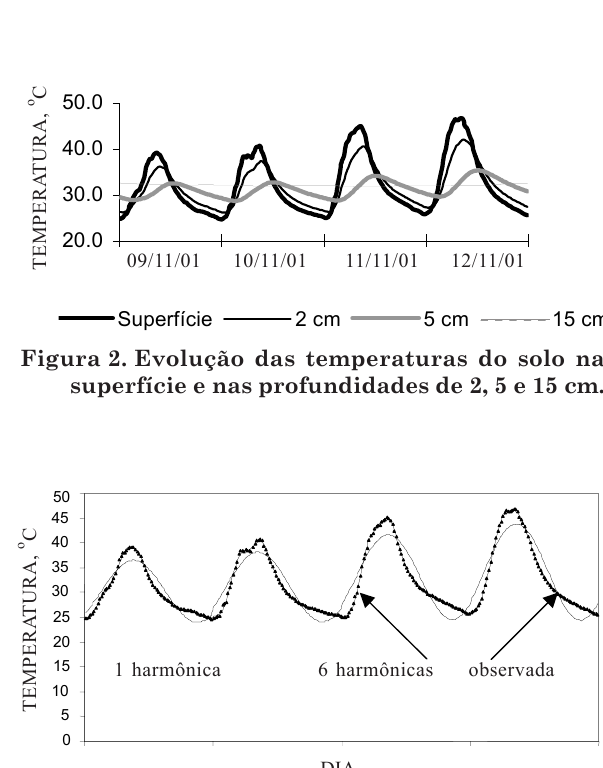
Figura 5. Difusividade térmica na camada de 0–15 cm, segundo os três métodos utilizados (CLTM, HM e